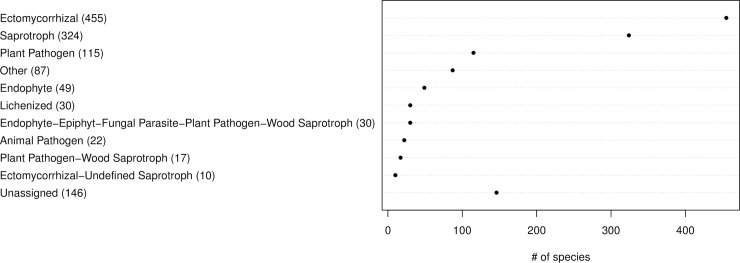
Ecological guilds of fungal taxa in belowground communities associated with Norway spruce.The taxa were classified into 47 ecological guilds with the FUNGuild tool and database [34]. For ease of reading, all guilds containing less than 10 taxa were grouped together as ‘Other’. See S2 Table for a complete list of assigned guilds.